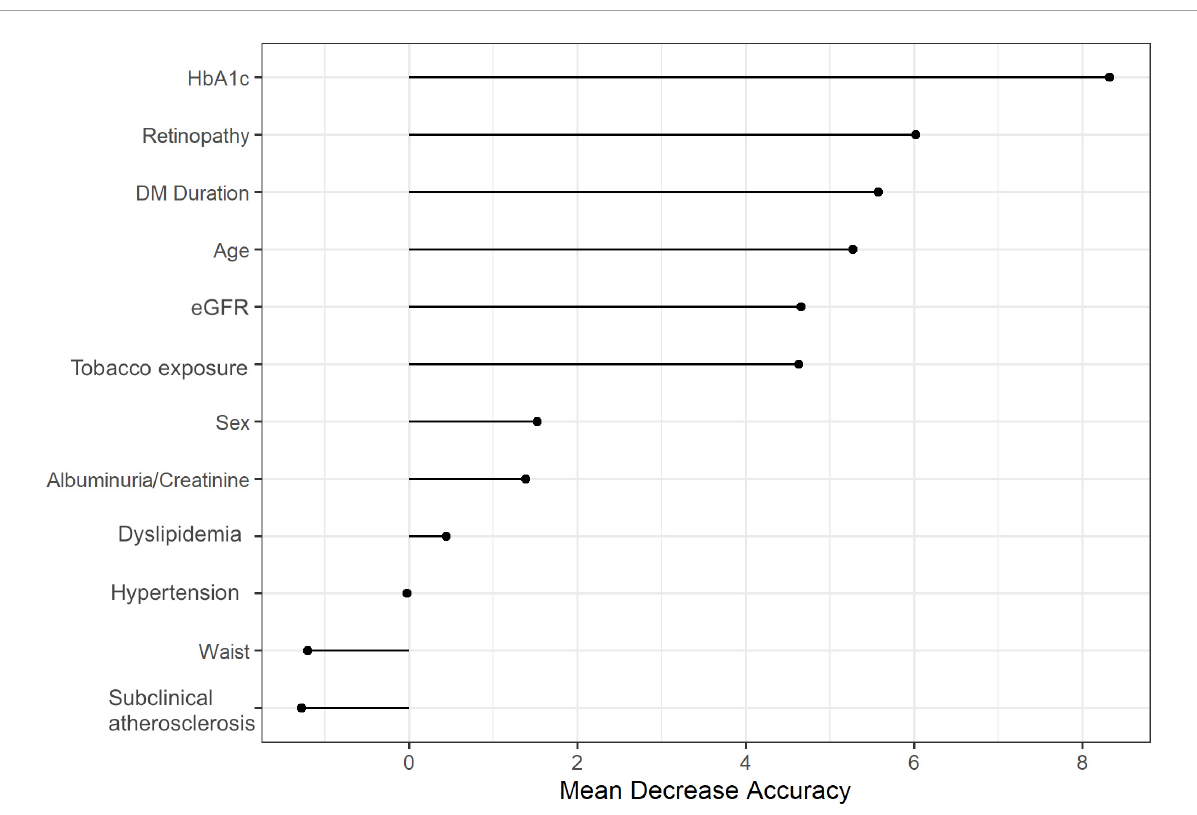
FIGURE1 Random forest of the relative importance of each variable in the multivariate model for the association between the presence of atherosclerotic plaque and diabetic retinopathy with cardiovascular events. HbA1c, glycated hemoglobin; DM_duration, diabetes mellitus duration; Plaque, presence of carotid plaques; eGFR, estimated glomerular filtration